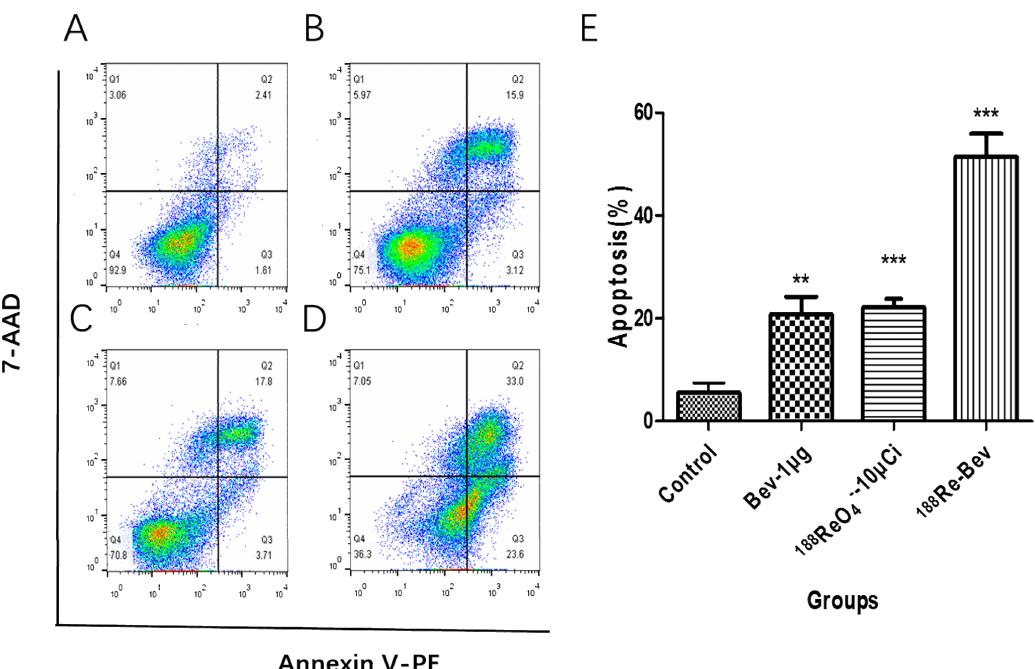
Figure 3. The percentage of apoptotic cells, inducing by bevacizumab ( B ); unbound 188 ReO 4 − ( C ) and 188 Re-bevacizumab ( D ) at equal concentration or radioactivity, untreated group as control ( A ). ( E ) The combined pro-apoptotic efficiency of 188 Re-bevacizumab is greater than the sum if each agent used along. ** p < 0.01; *** p < 0.001